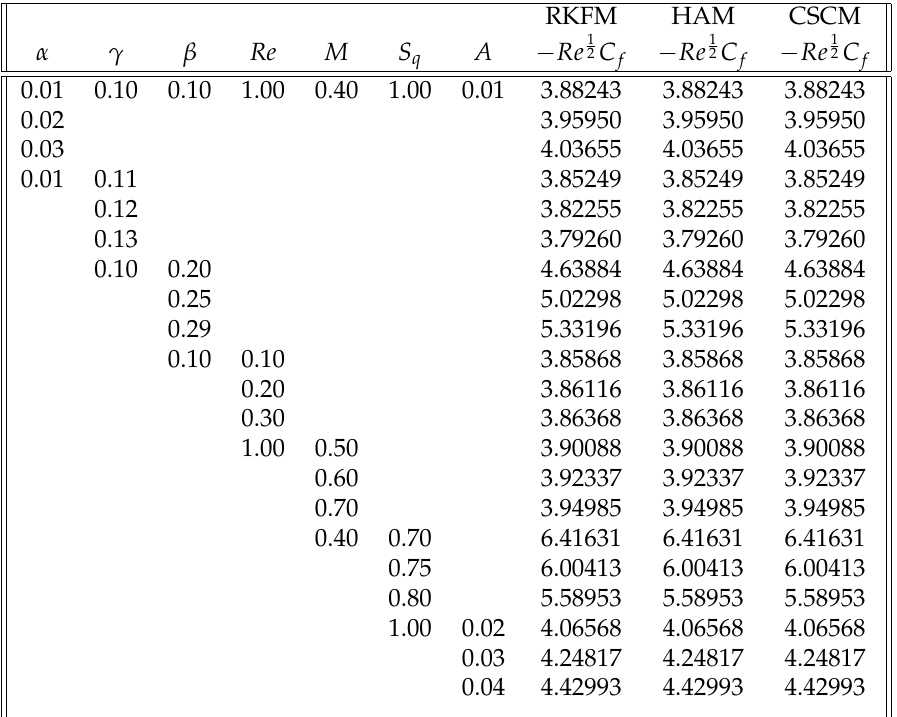
Table 1. Numerical values of Nusselt number for different parameter